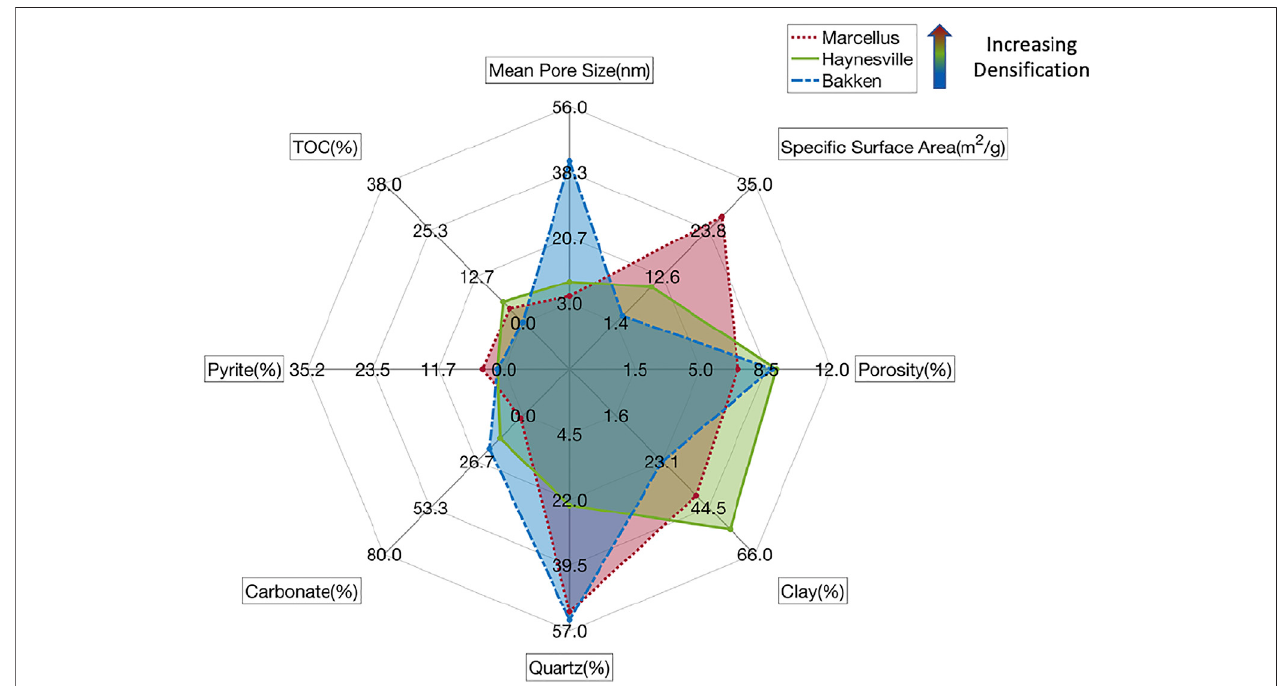
FIGURE 7 | Radar chart of all characterized shale properties for the Bakken, Haynesville and Marcellus samples and their relationship to gas densi fi cation.